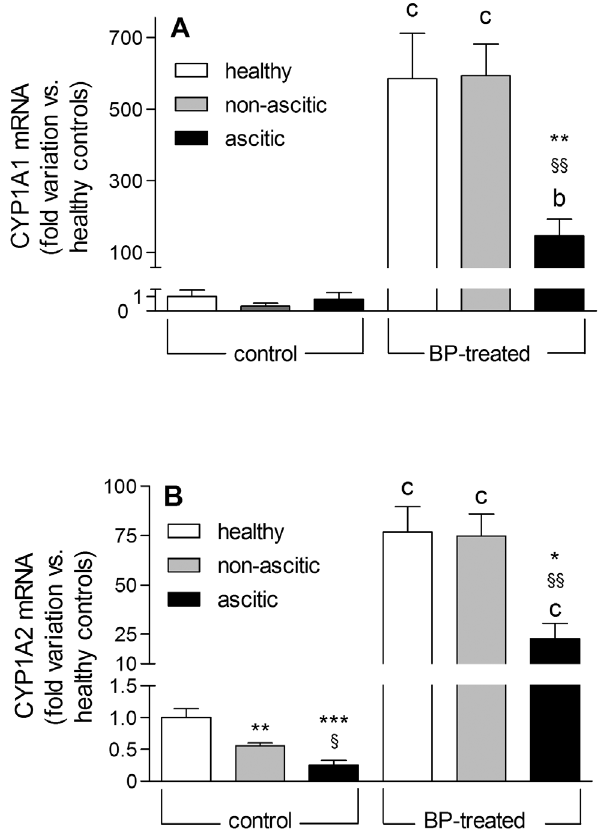
Figure 3. CYP1A1 and CYP1A2 gene transcription levels in control and BP-treated rats. The experimental data for CYP1A1 (A) and CYP1A2 (B) mRNA levels are reported as fold variation compared with healthy control rats. Results are means 6 S.E. of data obtained from 8 rats per group. *P , 0.05, **P , 0.01, ***P , 0.001 vs. healthy rats. 1 P , 0.05, 11 P , 0.01 vs. non-ascitic cirrhotic rats. b P , 0.01, c P , 0.001 vs. control rats of the same group.